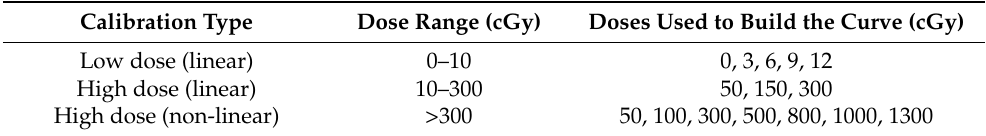
Table 1. Calibration levels. Dose levels used to build each calibration